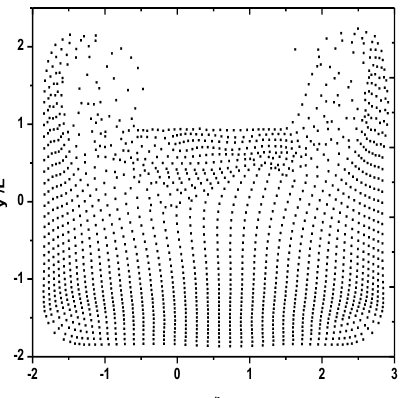
Fig. 4. Particle distributions for no boundary conditions.